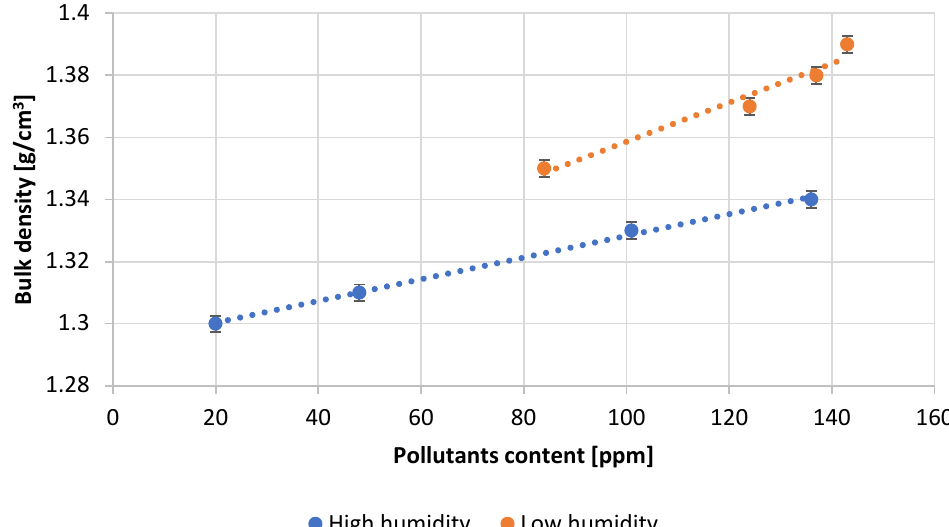
Figure 11. Dependence of bulk density of oxide on pollutants content.